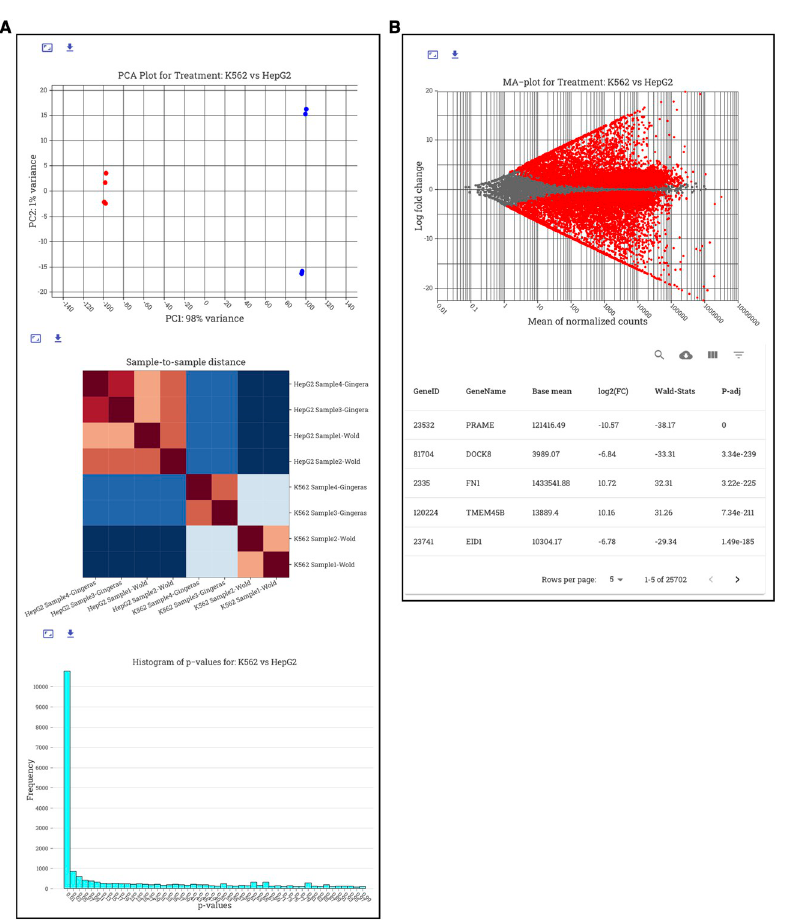
Fig 6. DESeq2 RNA-seq analysis visualized in STENCIL. (A) DESeq2 charts are visualized as dynamic charts in STENCIL. All data is generated and hosted directly from Galaxy. (B) The nivo charting library allows for on-the-fly generated of interactive plots containing tens of thousands of unique datapoint in